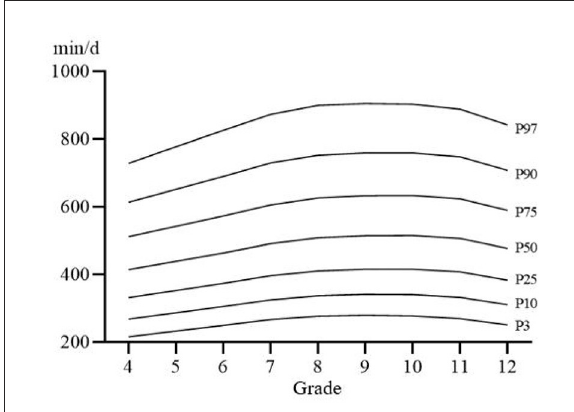
FIGURE1 The percentile distribution curve of total sedentary time.